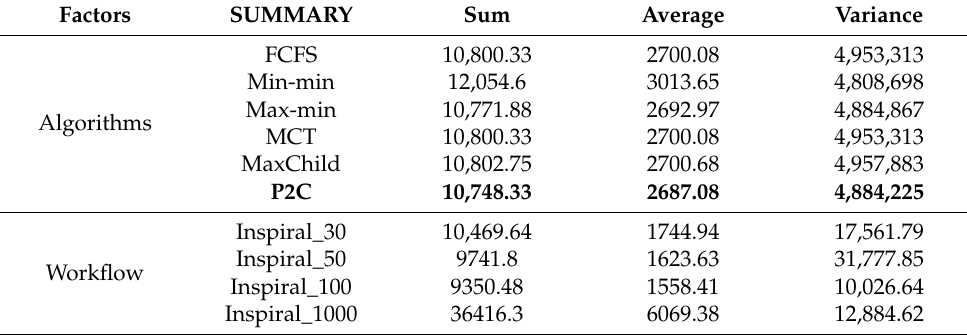
Table 12 clearly indicates that total and average execution time for inspiral workflow